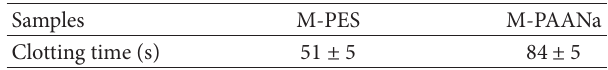
Table 1: APTTs for the M-PES and